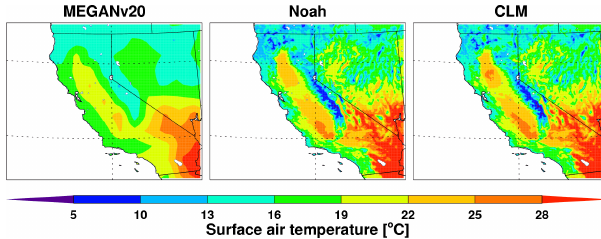
Figure 1. Spatial distributions of monthly mean surface air tem- perature in June 2010 from the MEGAN v2.0 climatology data set (MEANv20, prescribed) and the WRF-Chem simulations with the Noah (Noah, simulated) and CLM4 (CLM, simulated) land surface